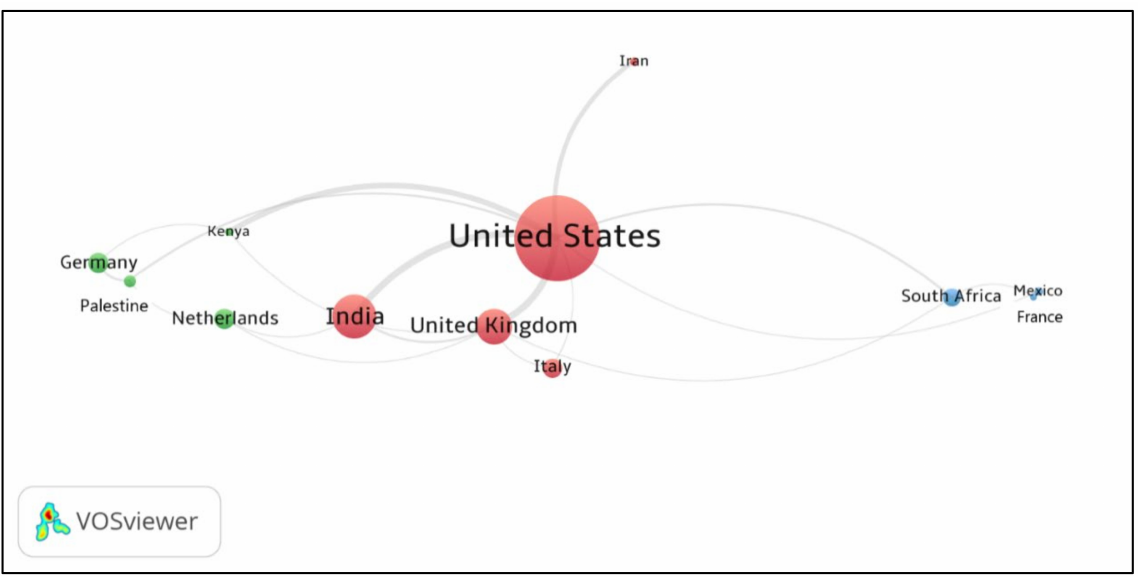
Figure 6. Countries’ collaboration map using network visualization maps. Five documents were specified as a threshold for each country. Twelve countries met the set threshold. The link thickness was used to indicate collaboration strength between countries. The circle that bounded the item (the country) indicates the contribution of each item based on the size of the circle (a country that has a higher contribution with respect to co-authorships has a larger circle compared to other